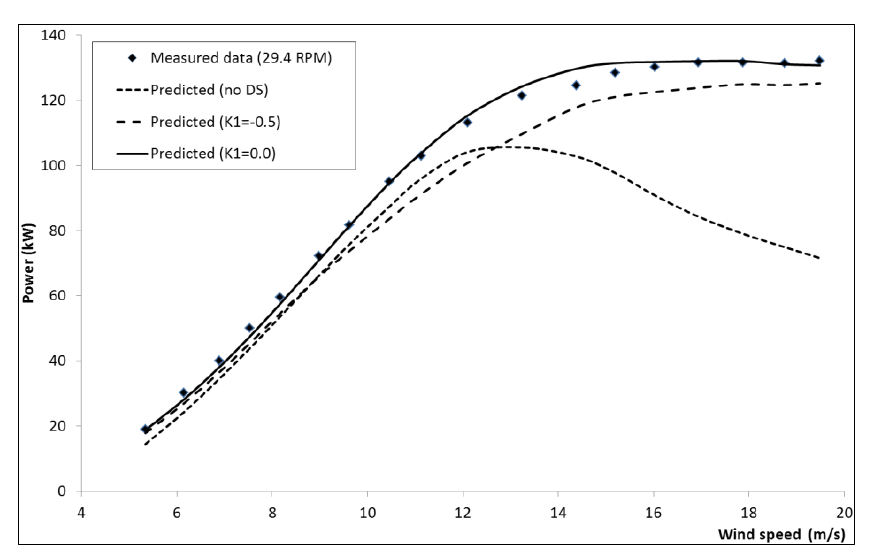
Figure 8. NRC 24m Φ-rotor power vs. wind speed at 29.4 rpm.